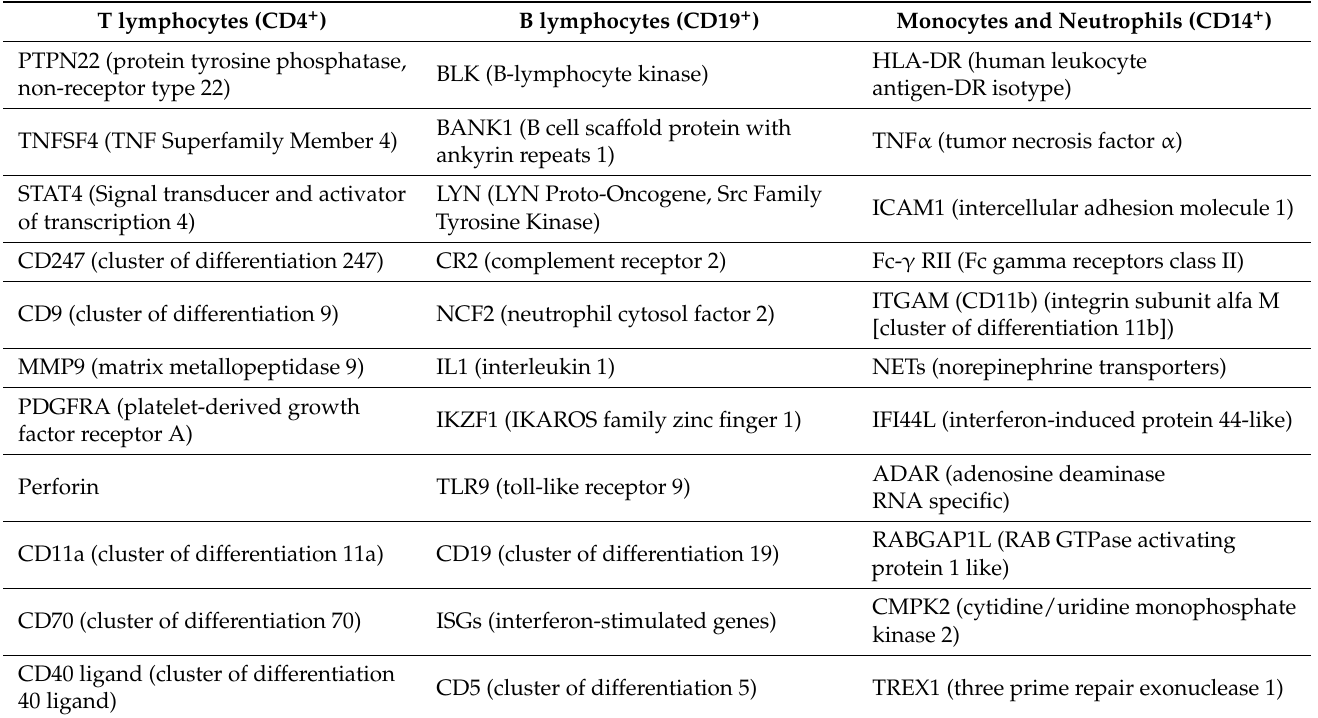
Table 1. Overview of genes associated with SLE in T lymphocytes, B lymphocytes, monocytes, and neutrophils. Listed genes only represent a fraction of all genes with altered methylation proportions found in SLE